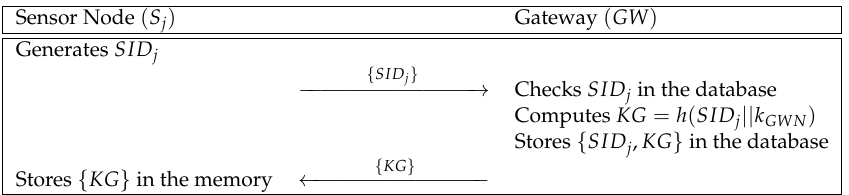
Figure 2. Sensor node registration phase of Moghadam et al.’s